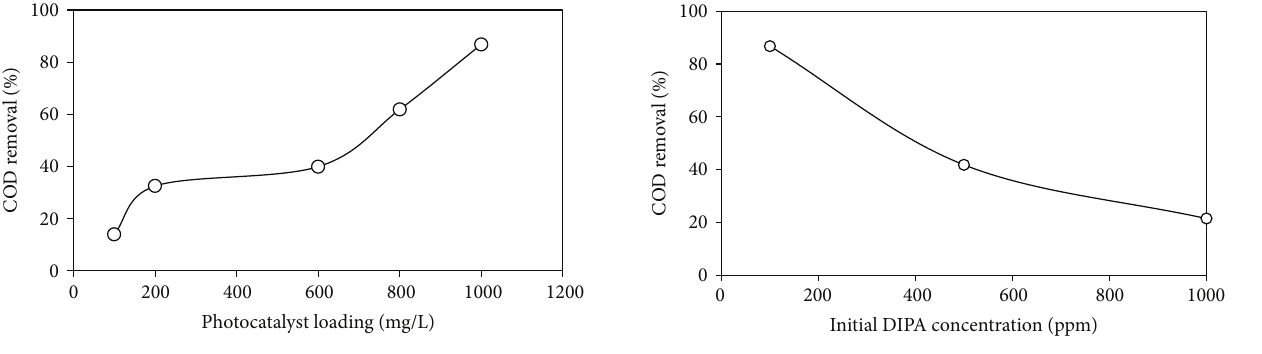
Figure 8: Effect of photocatalyst loading on photodegradation of DIPA using Cu-Ni/TiO 2 photocatalysts (photocatalysts loading = 100–1000 g ⋅ L −1 ; calcination temperature = 200 ∘ C; DIPA concentra- tion = 100 ppm; irradiation time = 1h).